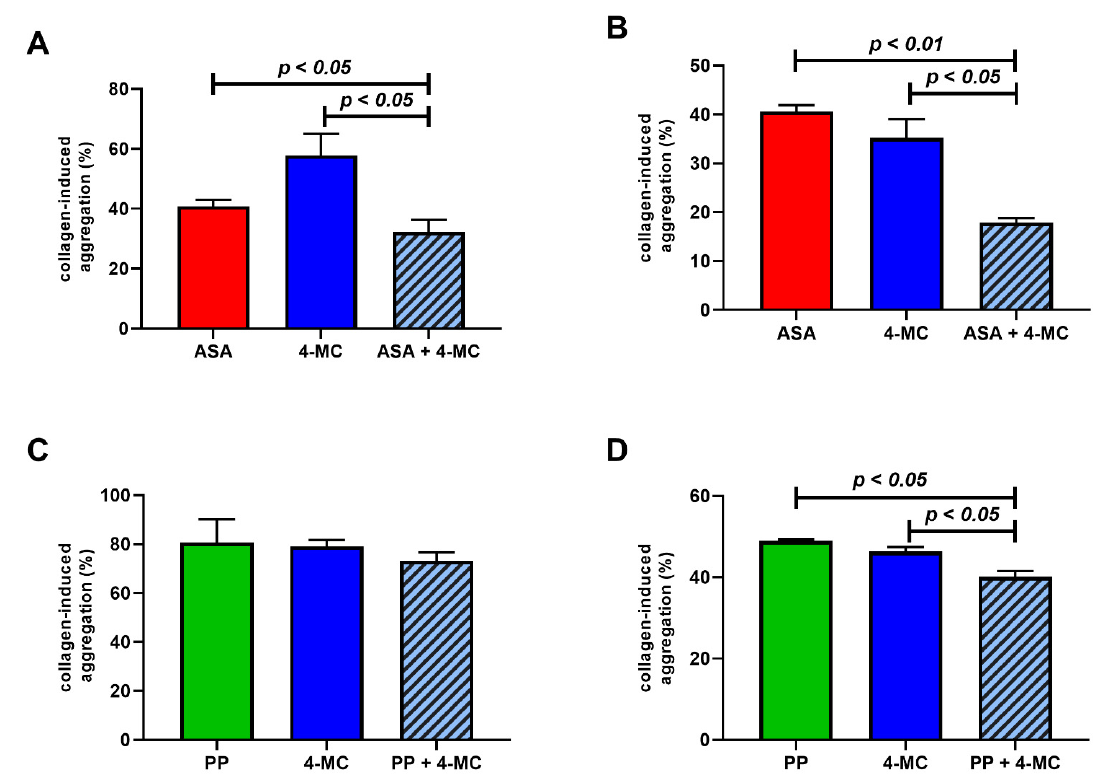
Figure 5. Investigation of the coadministration of 4-methylcatechol (4-MC) with known inhibitors on arachidonic acid-related aggregation pathways. ( A ) The effect of 4-MC, ASA and their combination on collagen-induced aggregation; blood was incubated with 5 µ M of 4-MC, 53 µ M of ASA and their combination, and aggregation was triggered by adding of collagen (final concentration of 0.5 µ g/mL). ( B ) The effect of 4-MC, ASA and their combination on collagen-induced aggregation; blood was incubated with 80 µ M of 4-MC, 53 µ M of ASA and their combination, and aggregation was triggered by adding collagen (0.4 µ g/mL). ( C ) The effect of 4-MC, pyrrophenone (PP) and their combination on collagen-induced aggregation; blood was incubated with 5 μ M of 4-MC, 200 nM of PP and their combination, and aggregation was triggered by collagen (0.16 μ g/mL). ( D ) The effect of 4-MC, PP and their combination on collagen-induced aggregation; blood was incubated with 123 μ M of 4-MC, 2 μ M of PP and their combination, and aggregation was triggered by adding collagen (0.16 μ g/mL).